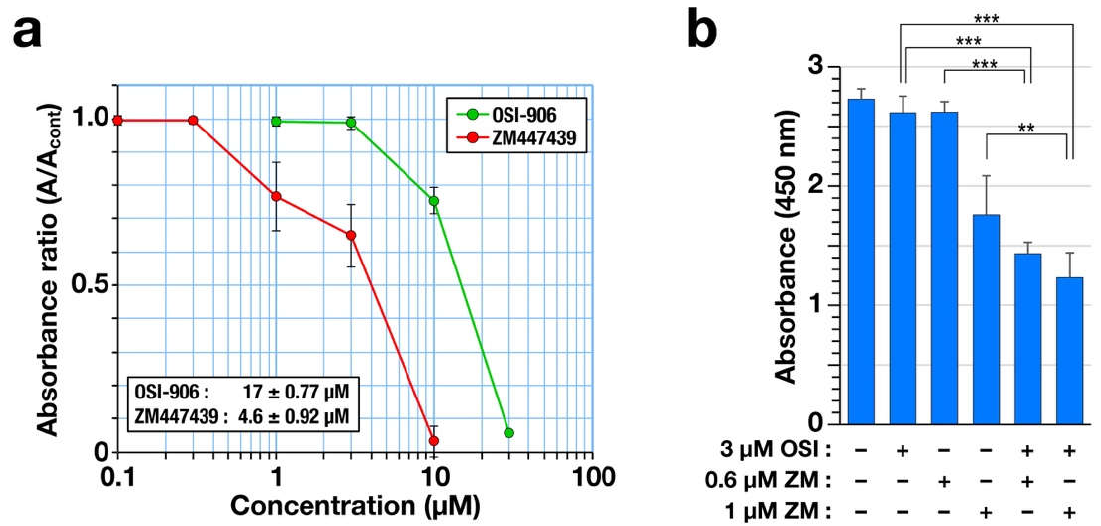
Figure 6. Combination of OSI-906 with ZM447439 reduces cell viability in the non-small cell lung cancer A549 cells. ( a ) The A549 cells were treated with OSI-906 or ZM447439 for 72 h, and cell viability was determined using a WST-8 assay. The relative absorbance ratios to the solvent control are plotted as mean ± SD calculated from three independent experiments. The IC 50 was calculated in each experiment and is shown as mean ± SD. ( b ) The A549 cells were treated with OSI-906, ZM447439, or their combination for 72 h; next, a WST-8 assay was performed. The absorbance is plotted as mean ± SD calculated from more than three independent experiments. The p -values were calculated using Tukey’s multiple comparison test. ** p < 0.01; *** p < 0.001.